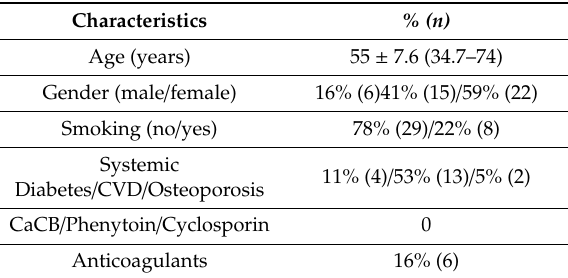
Table 1. General